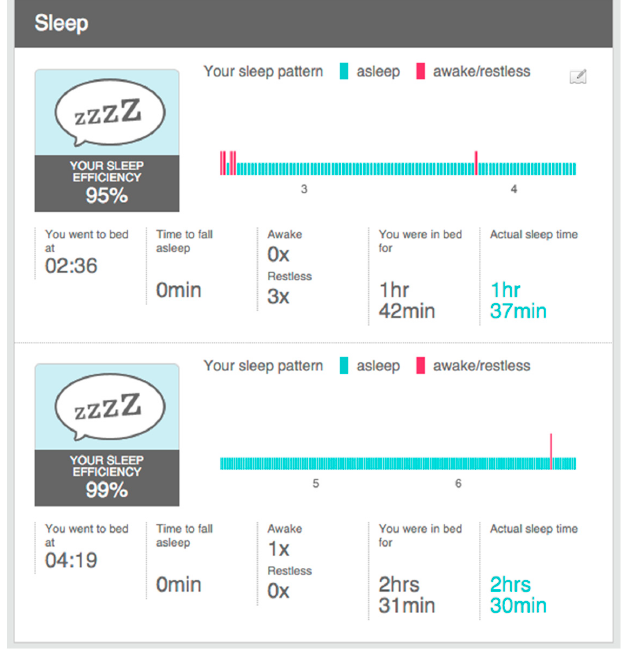
Figure 9): identification of sleep periods, the number of awakes, time to fall asleep, total time, and real time.